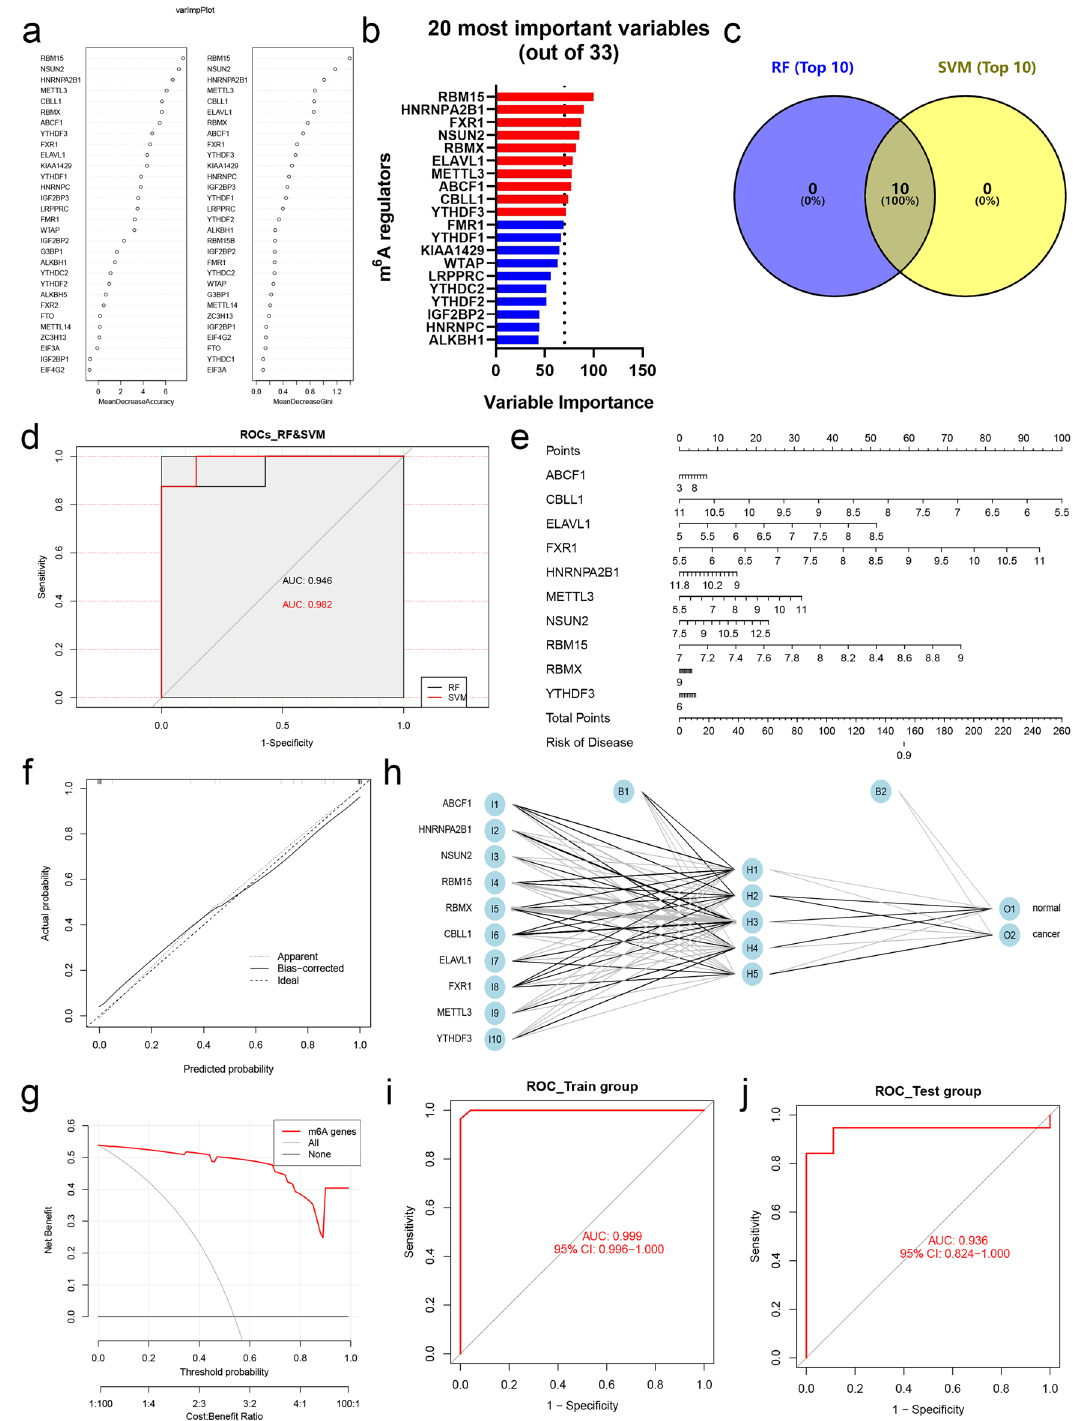
Figure 2. Diagnostic model construction and key m 6 A regulators identification. ( a ) Variable importance screening based on RF. ( b ) Variable importance screened via SVM. ( c ) Venn diagram showed the top 10 candidate regulators contained both in RF and SVM. ( d ) ROC curves based on machine learning methods for diagnostic probabilities. ( e ) The nomogram diagnostic prediction model based on ten filtered m 6 A regulators. ( f ) The calibration plots suggested the comparison between prediction and actual outcome for incidence probabilities in the nomogram model. ( g ) The decision curve analysis showed the net benefit in the nomogram model. ( h ) Establishment of CC diagnosis model with m 6 A factor as input layer based on ANN method. ( i ) ROC curves described the predictive ability of ANN model for CC incidence probabilities with the GSE63514 as train group. ( j ) ROC curves described the predictive ability of ANN model for CC incidence probabilities with the GSE6791 as test